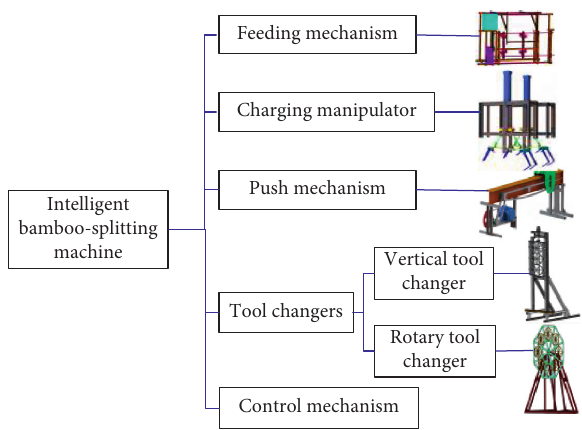
Figure 2: Overall structure of intelligent bamboo-splitting machine.